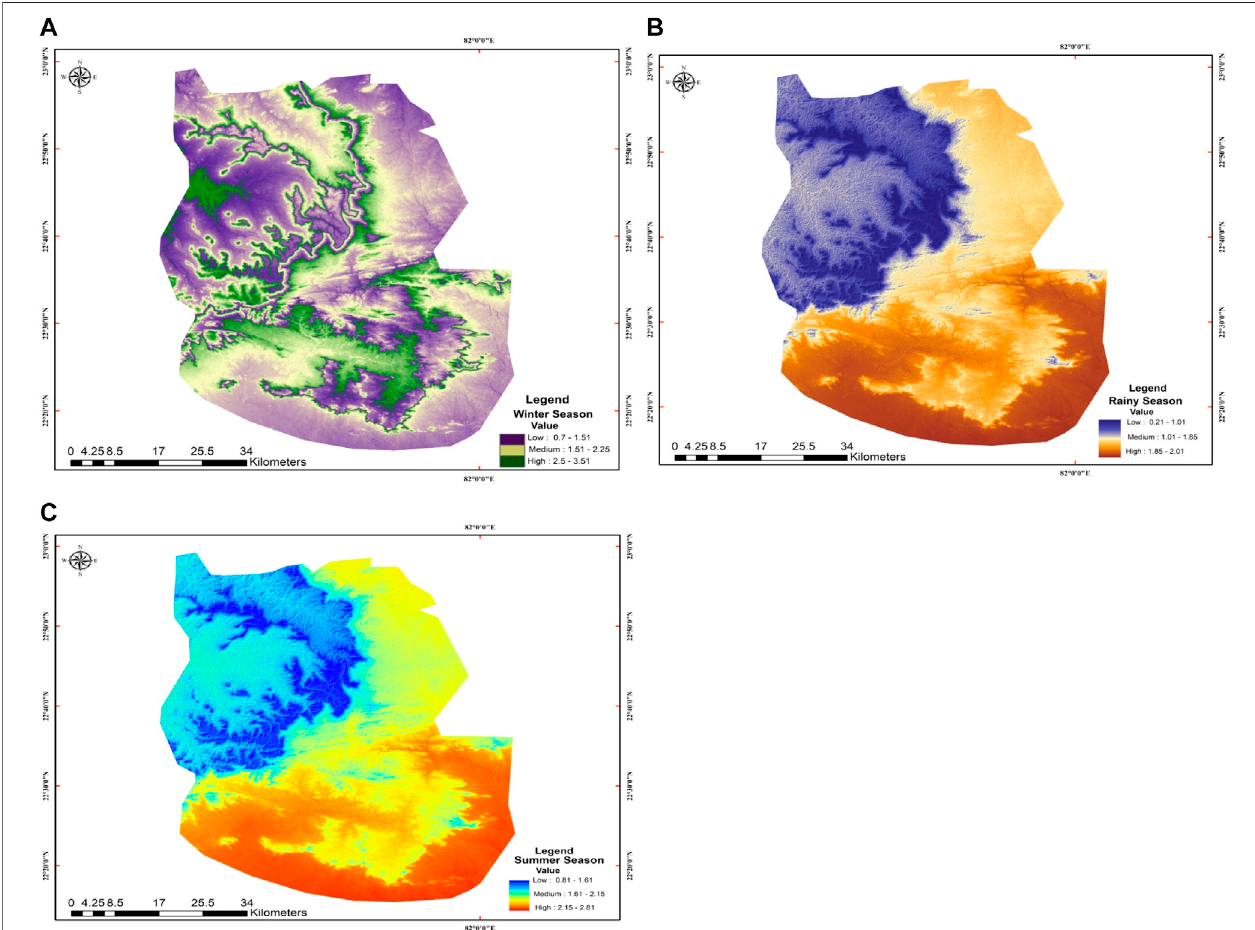
FIGURE5| Seasonallitterfall(Mg/ha) ofdifferentvegetation types inAABRshowingsustainable litterfallpattern. (A) :winterseason. (B) : rainyseason. (C) :summer season.